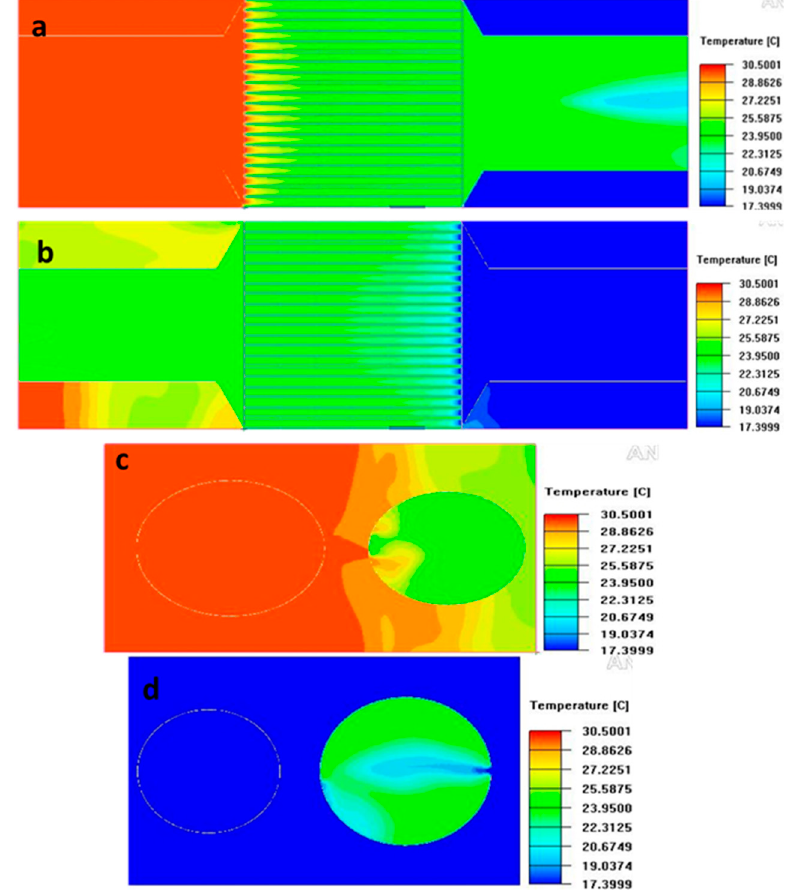
Figure 10. ( a ) Temperature cloud diagram in the polluted air duct; ( b ) Temperature cloud diagram in the fresh air tunnel; ( c ) Temperature cloud diagram of inlet surface of polluted air and outlet surface of fresh air; ( d ) Temperature cloud diagram of inlet surface of fresh air and outlet surface of polluted